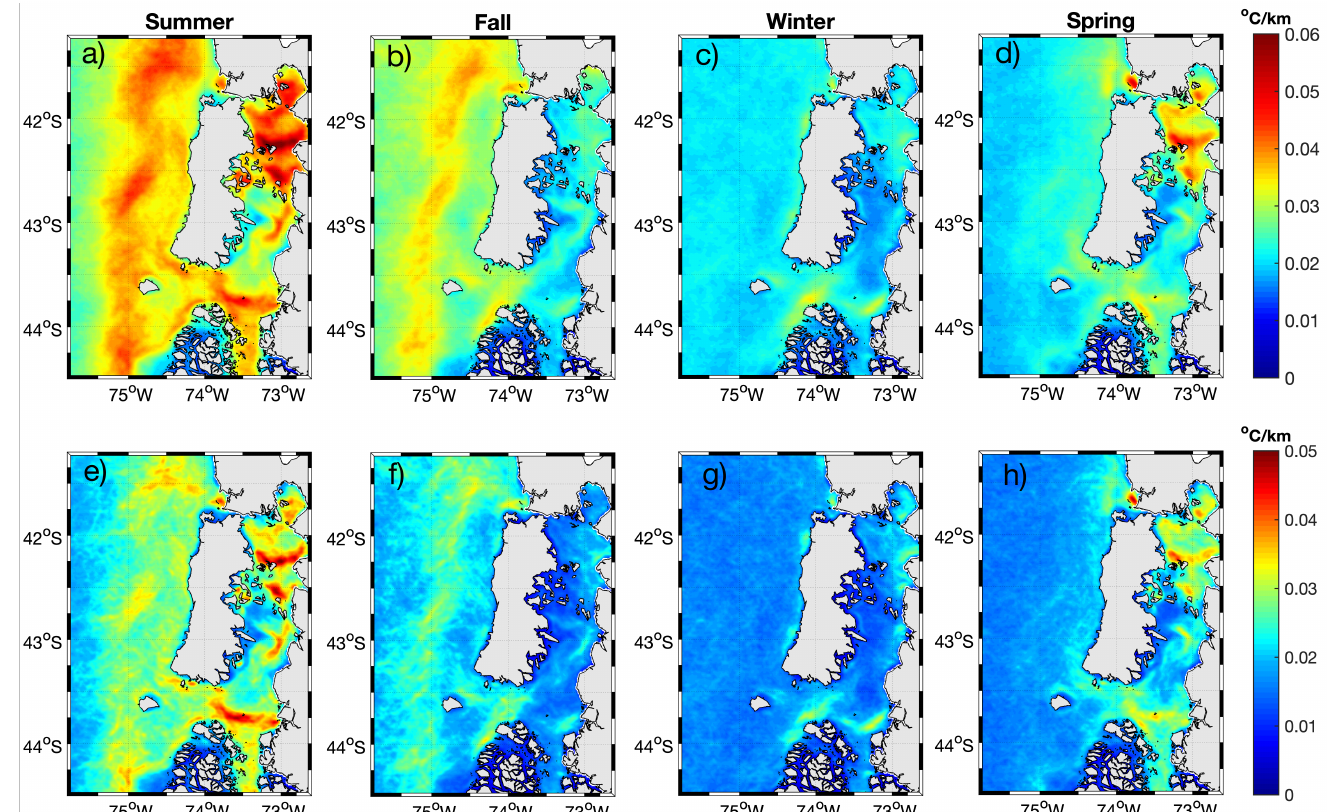
Figure 3. Seasonal climatology (2003–2019) of gradient magnitude of SST in the Inner Sea of Chiloé and its adjacent coastal ocean. (upper panels) averages and (lower panels) standard deviations for ( a , e ) summer (January, February, March), ( b , f ) fall (April, May, June), ( c , g ) winter (July, August, September), and ( d , h ) spring (October, November, December). For reference of locations see Figure